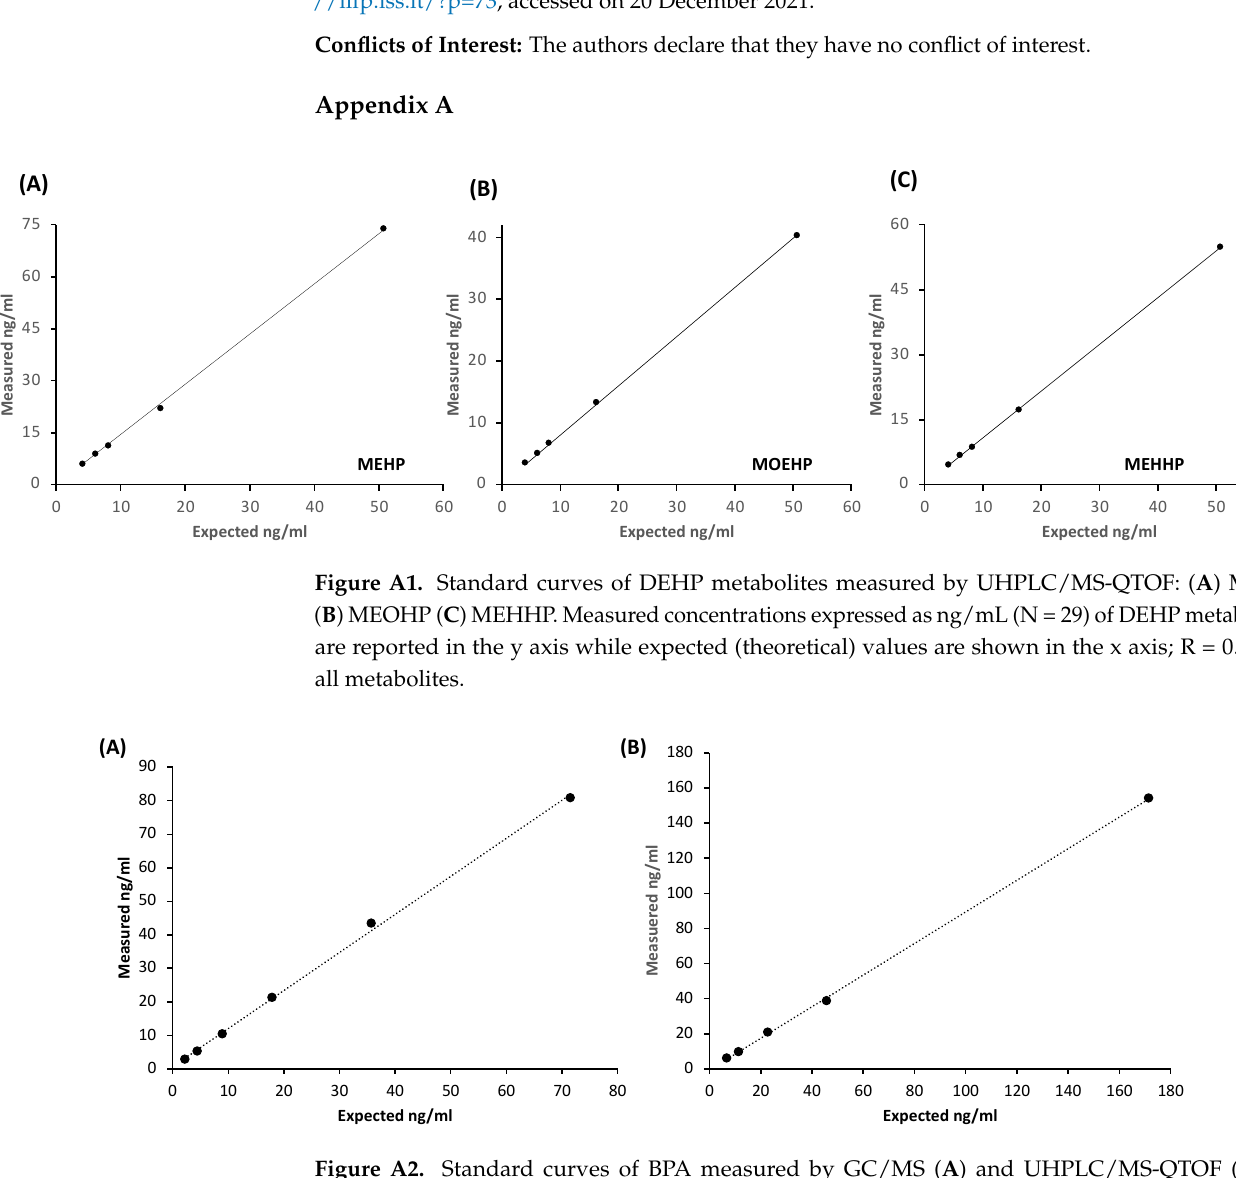
Figure A2. Standard curves of BPA measured by GC/MS ( A ) and UHPLC/MS-QTOF ( B ), as ng/mL. The graphs show measured concentrations ( y axis) vs expected values ( x axis); R = 0.99 for both analyses.